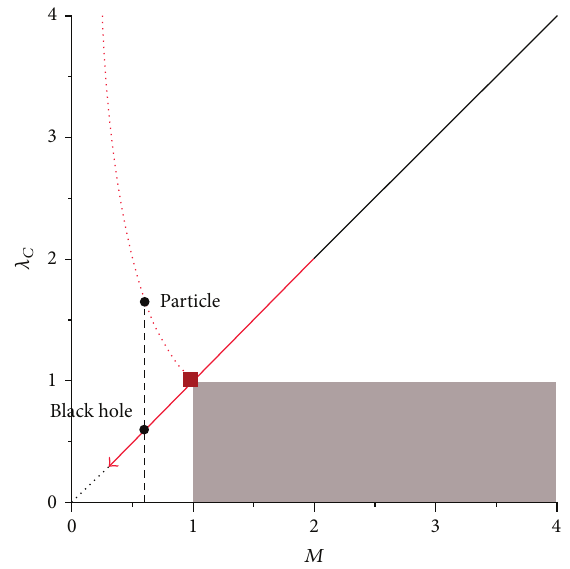
Figure 1: The dotted and the solid curves represent the particle Compton wavelength 𝜆 𝐶 and the Schwarzschild radius as a function of the energy 𝑀 in Planck units (quantities are rescaled). The squared bullet is the Planck scale. The grey area of the diagram is actually excluded, meaning that a particle cannot be compressed at distances smaller than the Planck length: at trans-Planckian energy only black hole form. The arrow shows the inadequacy of the Schwarzschild metric: black holes have no lower mass bounds, can have size smaller than the Planck length, and can expose the curvature singularity by decaying through the Hawking